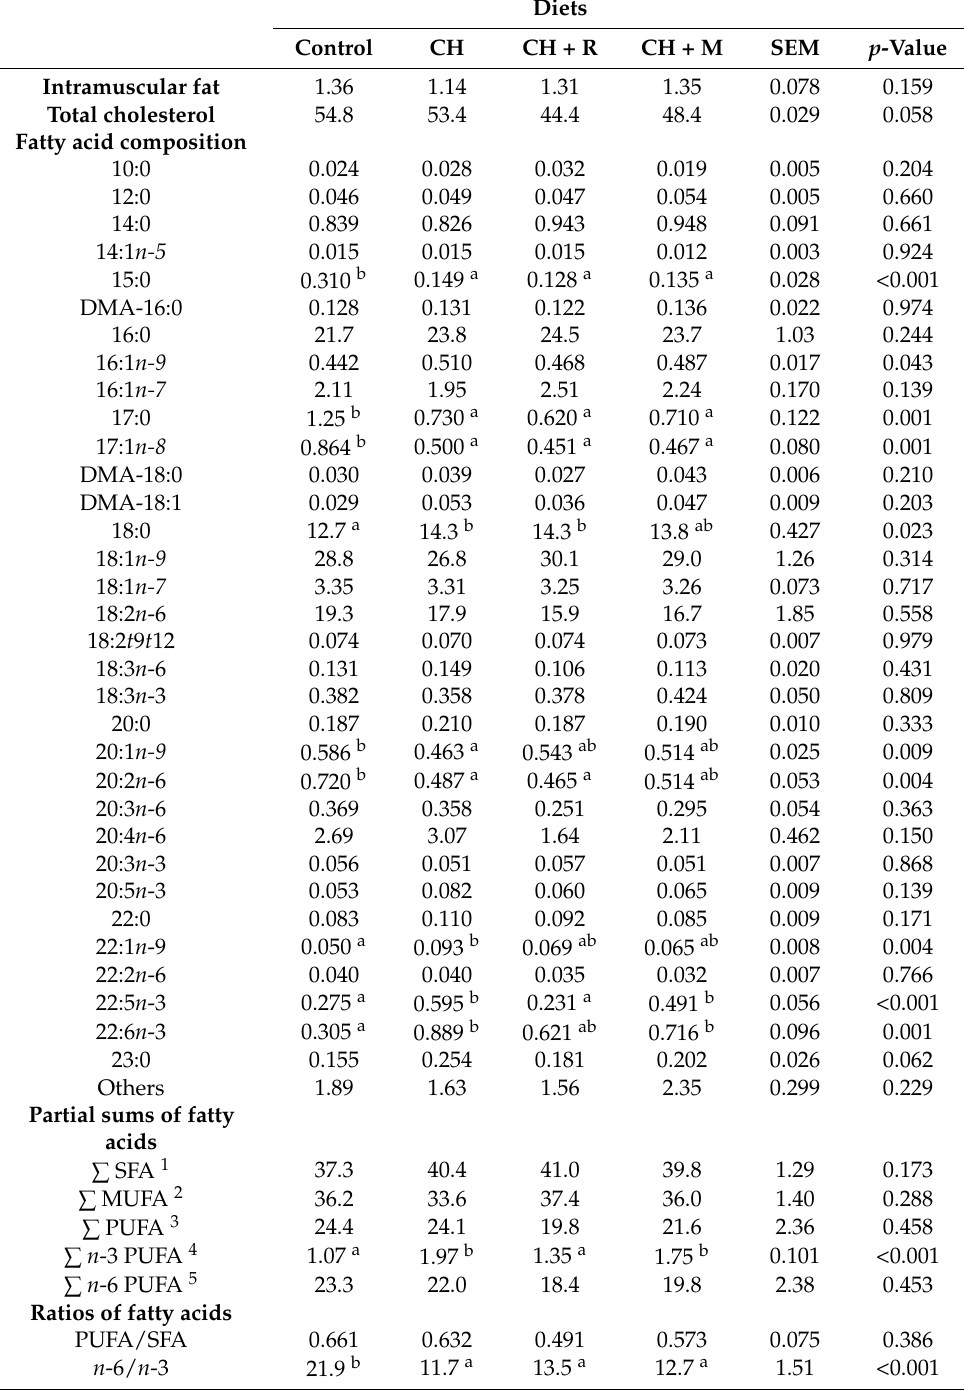
Table 5. Effect of experimental diets on intramuscular fat content (g/100 g muscle), total cholesterol (mg/100 g muscle), and fatty acid (FA) composition (% of total FA) in longissimus lumborum